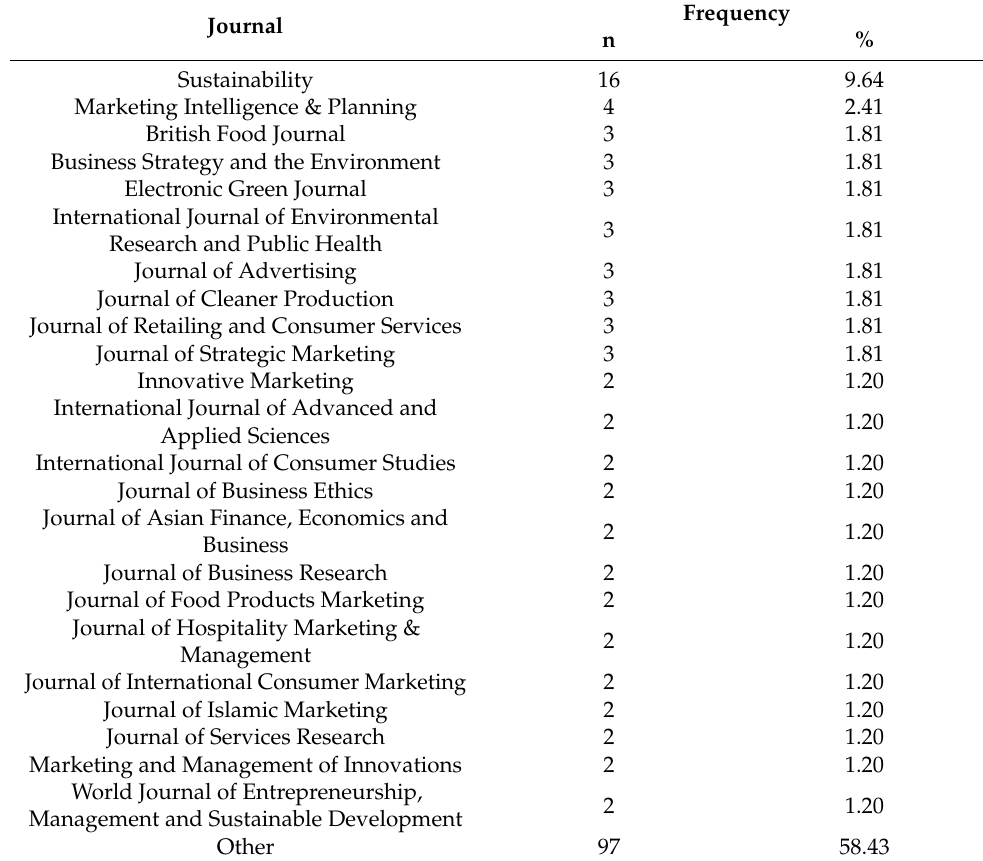
Table 1. The number of papers published per